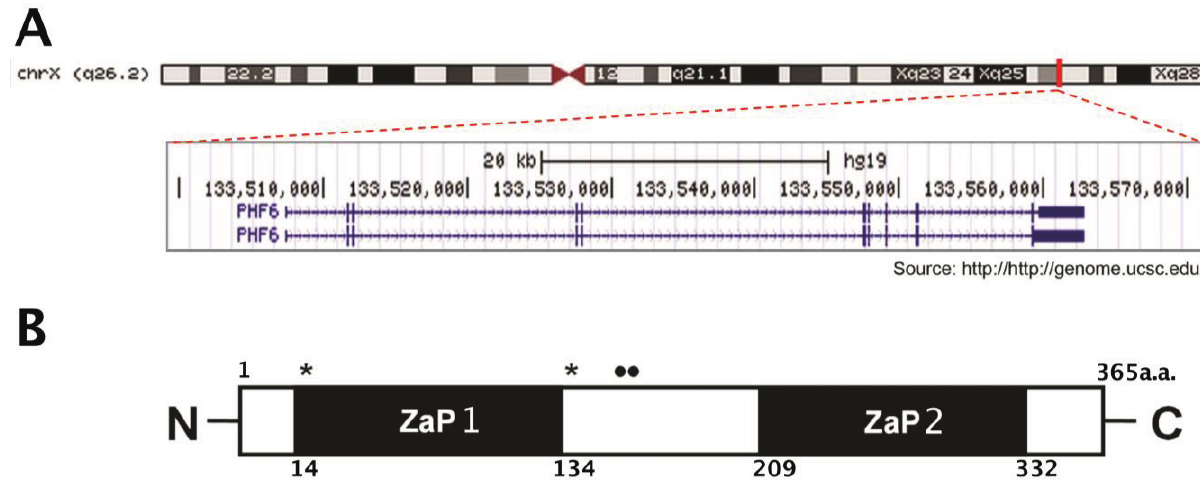
Figure 1. PHF6 gene and protein domain structures. ( A ) The PHF6 gene contains 11 exons and is located on the X chromosome. Source: UCSC Genome Browser